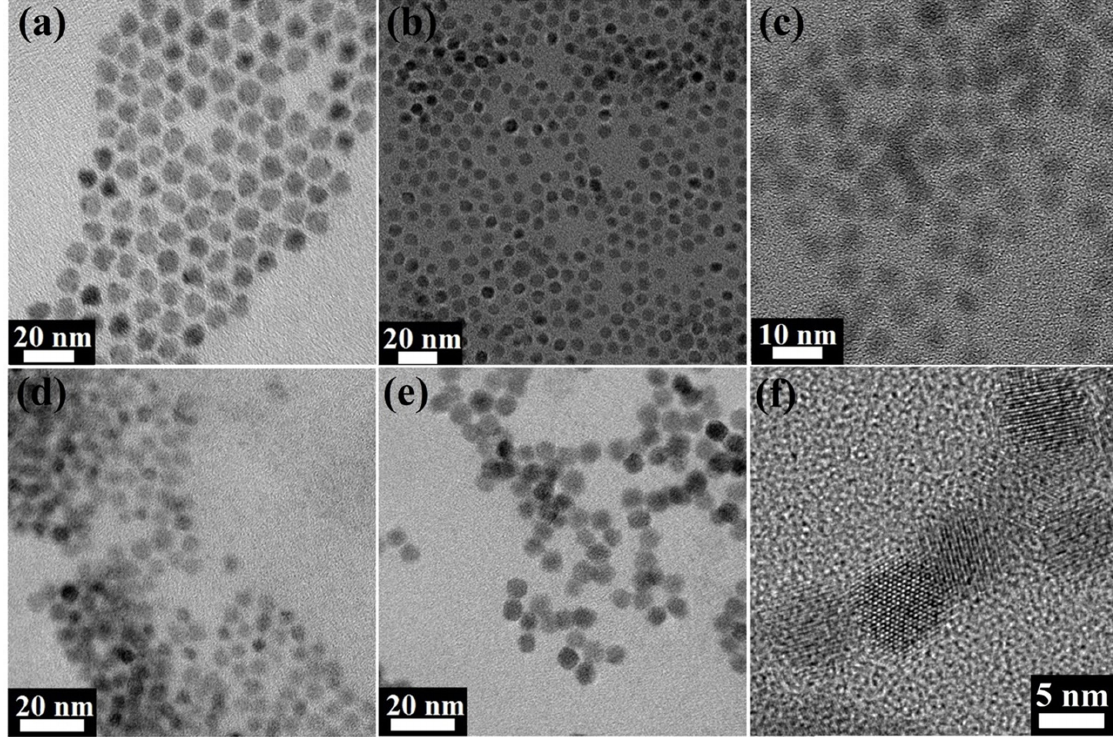
Figure 2. TEM and HRTEM images of ( a ) as-synthesized PbS QDs capped with oleic acid, with an interparticle distance of 10 . 2 ± 0 . 8 nm; ( b ) PbS QDs after 1,3-BDT treatment, with an interparticle distance of 9 . 3 ± 0 . 8 nm; ( c ) PbS QDs after EDT treatment, with an interparticle distance of 7 . 8 ± 0 . 8 nm; ( d ) PbS QDs after MPA treatment, with an interparticle distance of 7 . 6 ± 0 . 8 nm; ( e ) PbS QDs after (NH 6 . 7 ± 0 . 8 nm; ( f ) high-resolution TEM images of the (NH